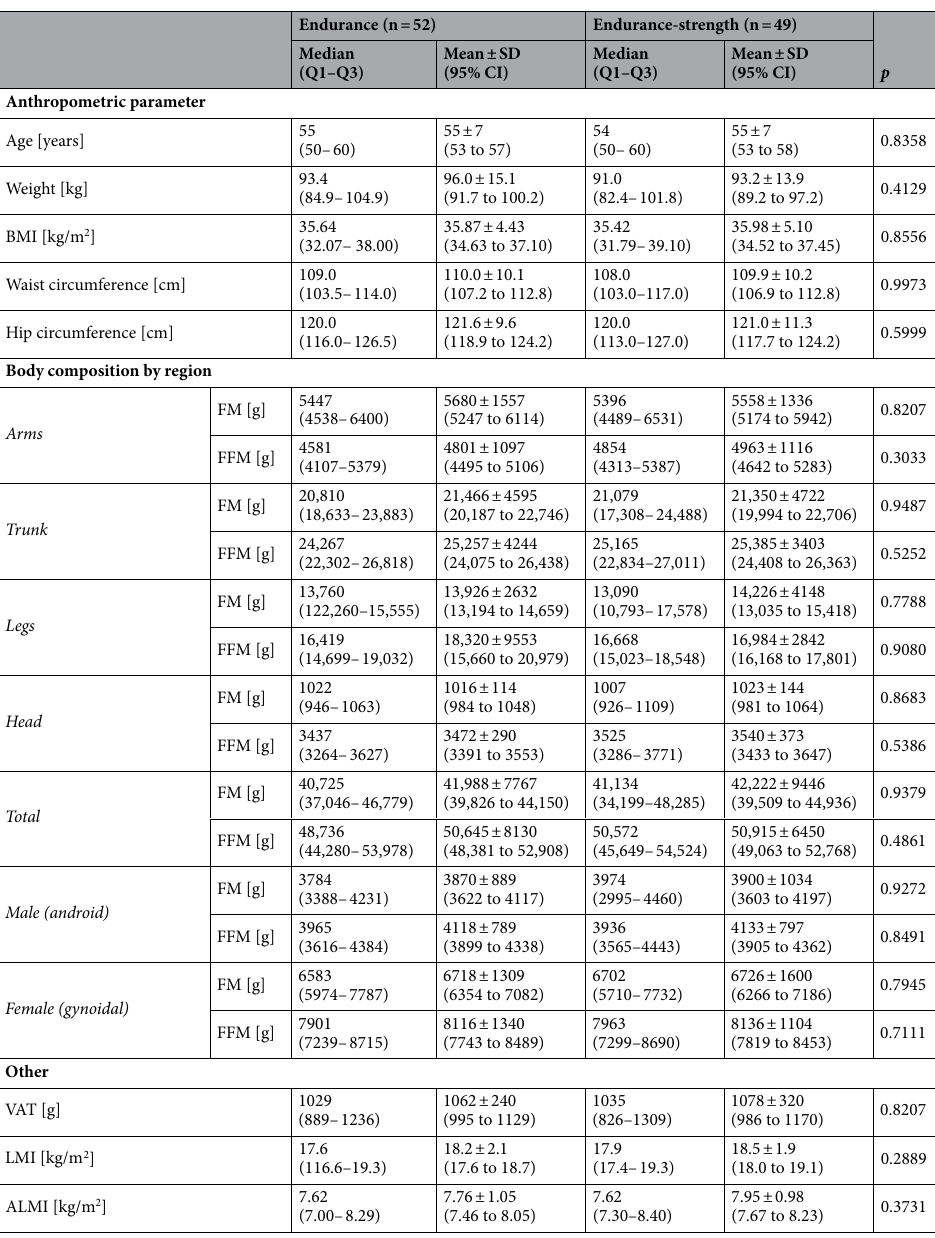
Table 1. Anthropometric characteristics of the study population (n = 101). ALMI appendicular lean mass index, BMI body mass index, FFM free fat mass, FM fat mass, LMI lean mass index, VAT visceral adipose